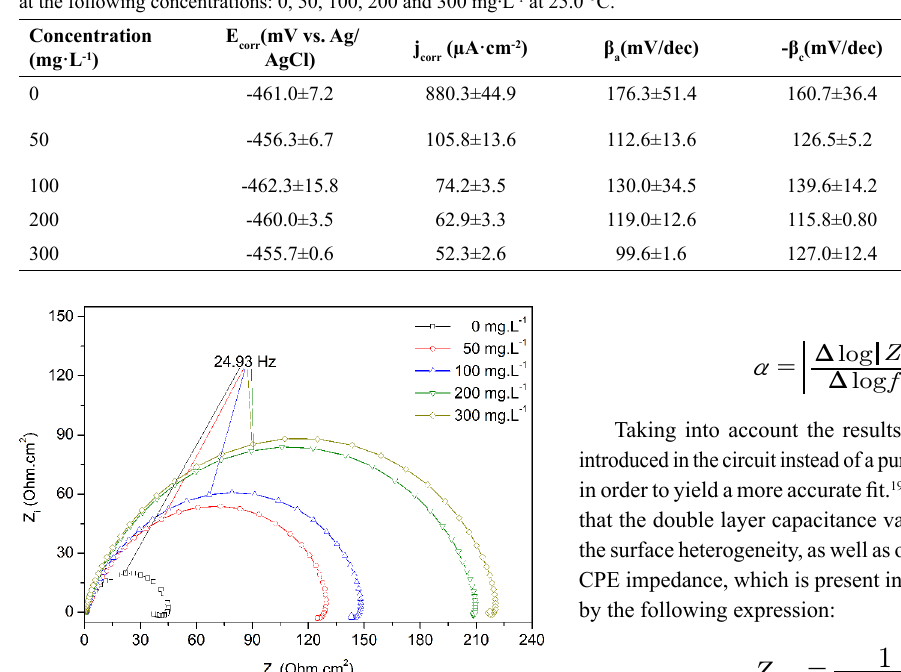
Figure 5. Nyquist plots obtained at the corrosion potential for C-steel in 1.0 mol∙L -1 HCl without and with the ethanolic Aniba canelilla extract at 25.0 °C. Concentrations: 0, 50, 100, 200 and 300 mg∙L -1 .